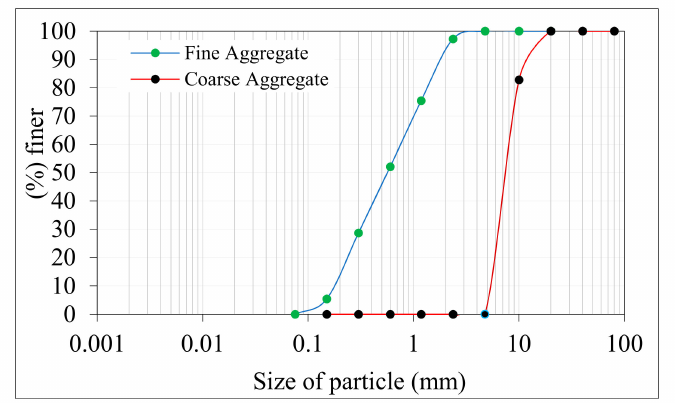
Figure 4. Gradiometric curve for the used aggregates.